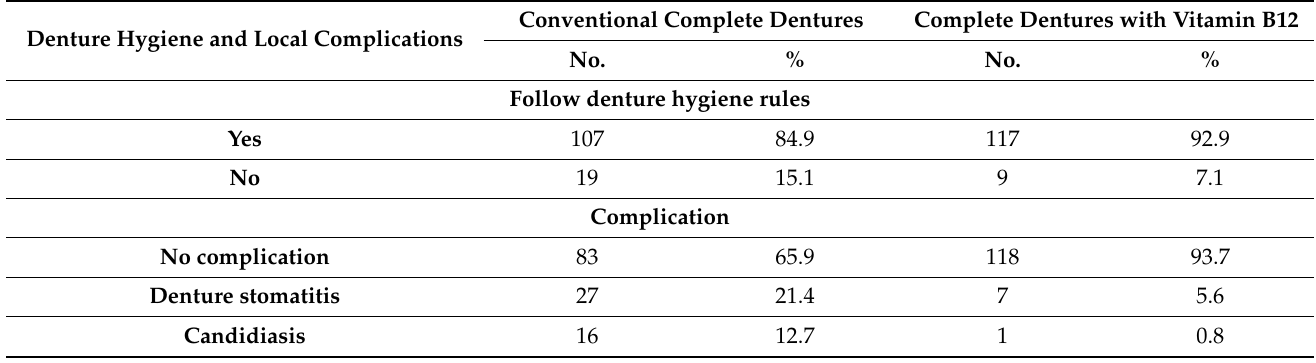
Table 2. Distribution of participants according to denture hygiene and local complications.